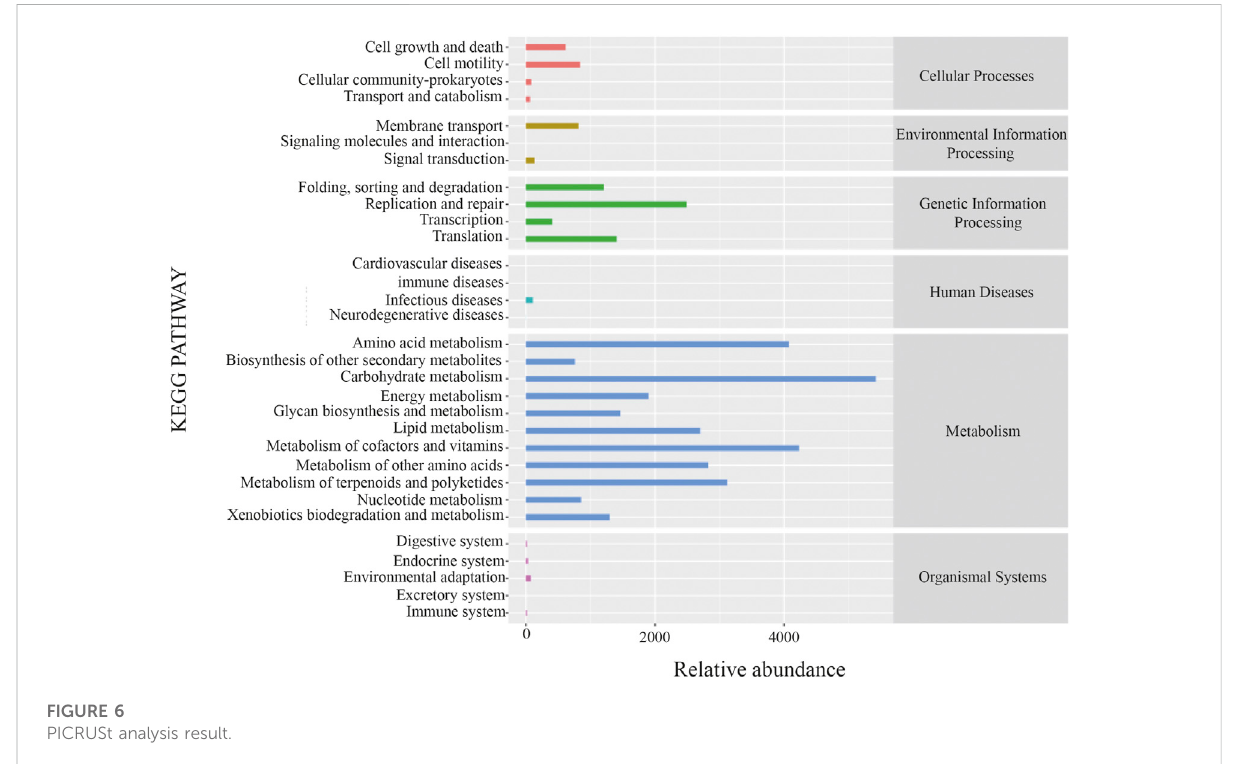
FIGURE 6 PICRUSt analysis result.